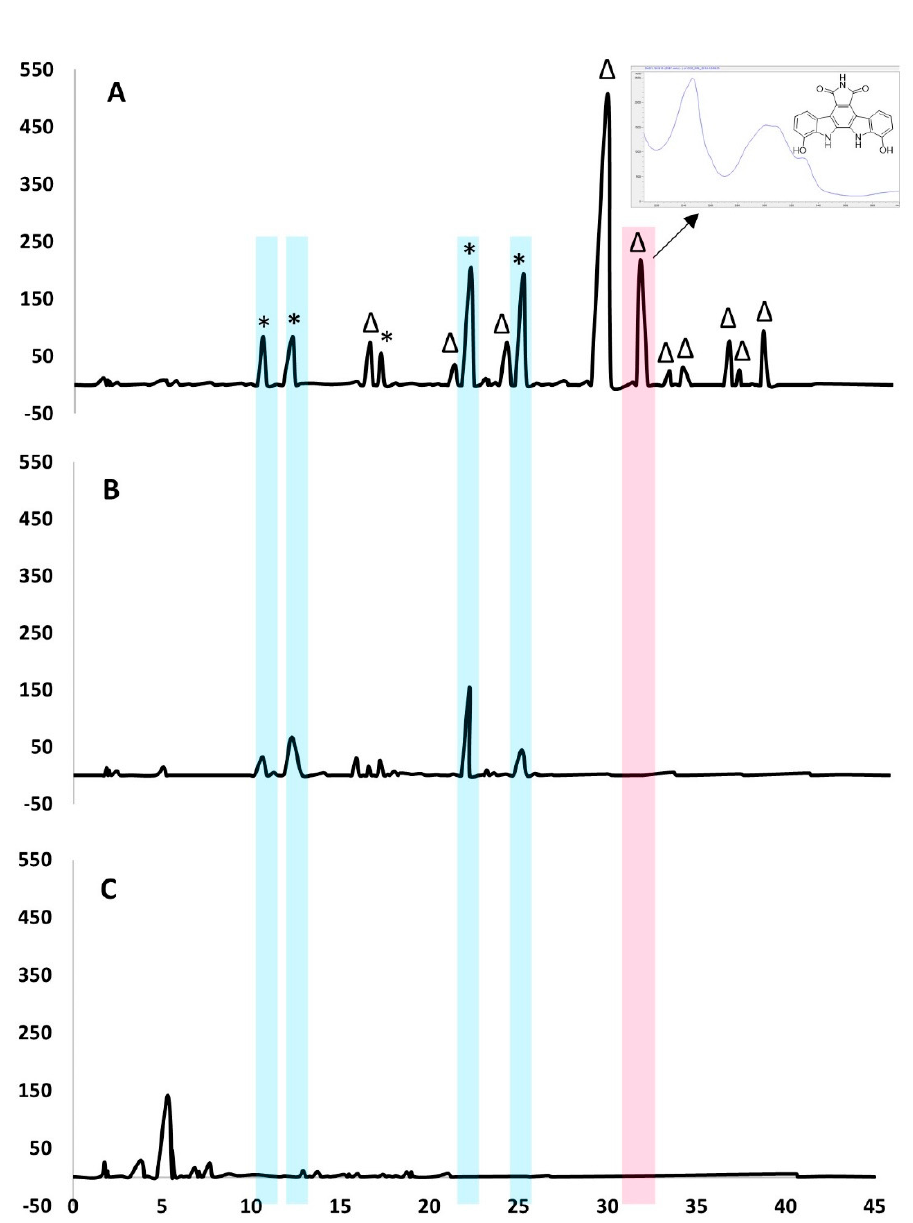
Figure 2. ( A ) HPLC traces recorded at λ 250 nm of the extracts (10 µ L injection, 15.0 mg / mL in methanol) of Streptomyces sp. MA37 cultivated with Pseudomonas sp., showing metabolites that are upregulated ( * ) and expressed only in co-cultures ( ∆ ). ( B ) Streptomyces sp. MA37 monoculture, and ( C ) Pseudomonas sp. monoculture.